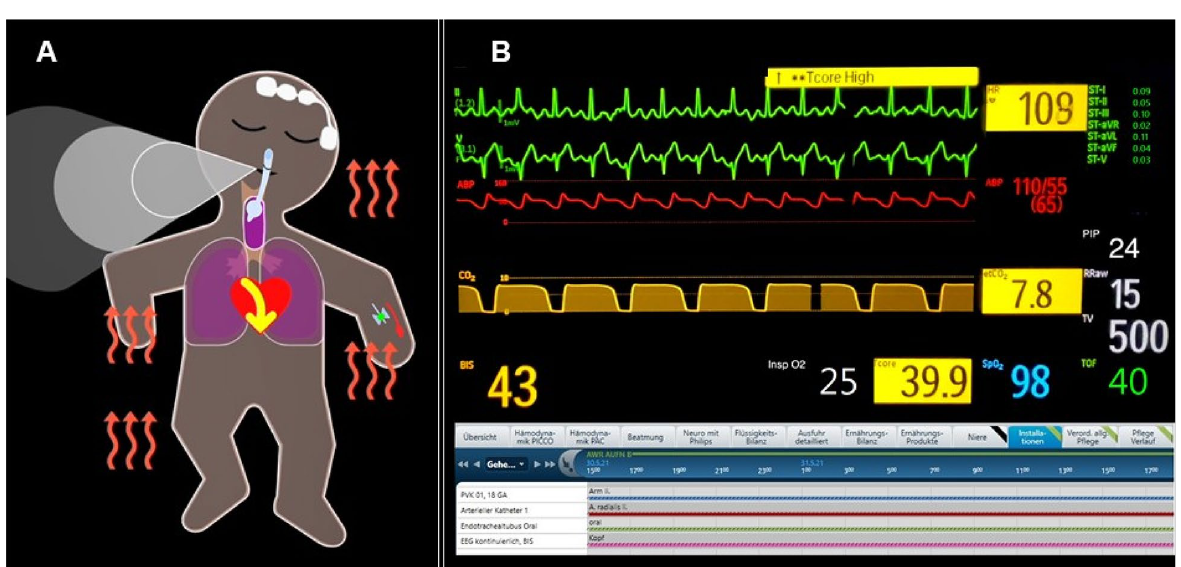
Figure 2. Exemplary scenario depicted in both modalities. ( A ) Visual-Patient-avatar ICU and ( B ) the corresponding conventional patient monitor used in Switzerland. For example, the large extension of the CO 2 cloud designates too high end-tidal carbon dioxide, while the floppy extremities indicate a deep neuromuscular relaxation. Tachycardia is only visible in the animated image as rapid pulsations. We adjusted the units and labellings’ language of the conventional patient monitor country specifically. etCO 2 end-tidal carbon dioxide, HR Heart rate, Tcore Core temperature, PIP Peak inspiratory pressure, ABP Arterial blood pressure, TV Tidal volume, TOF Train of four ratio, Insp O 2 Inspiratory oxygen concentration, BIS Bispectral Index, RRaw Respiratory rate, SpO 2 peripheral oxygen